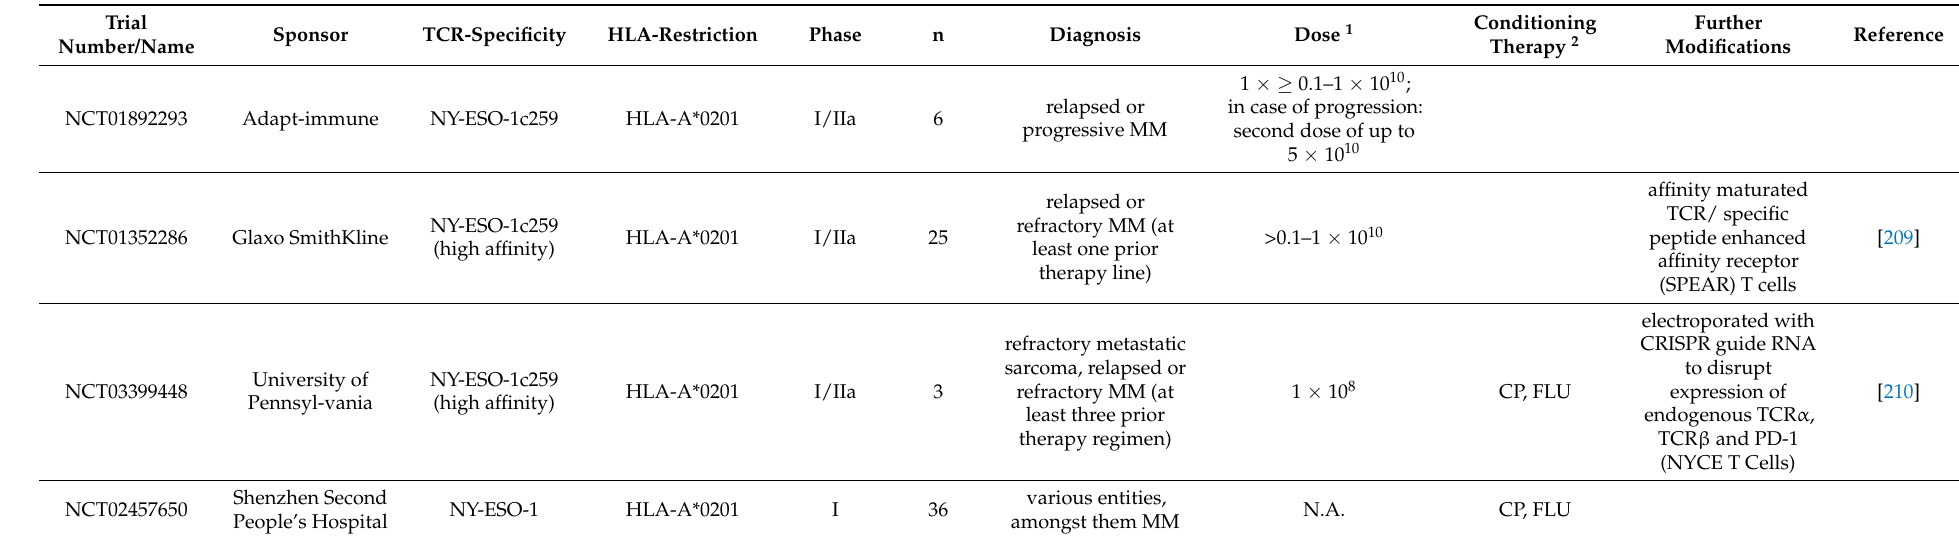
Table 4. Clinical trials for TCR-based therapy in MM (information from